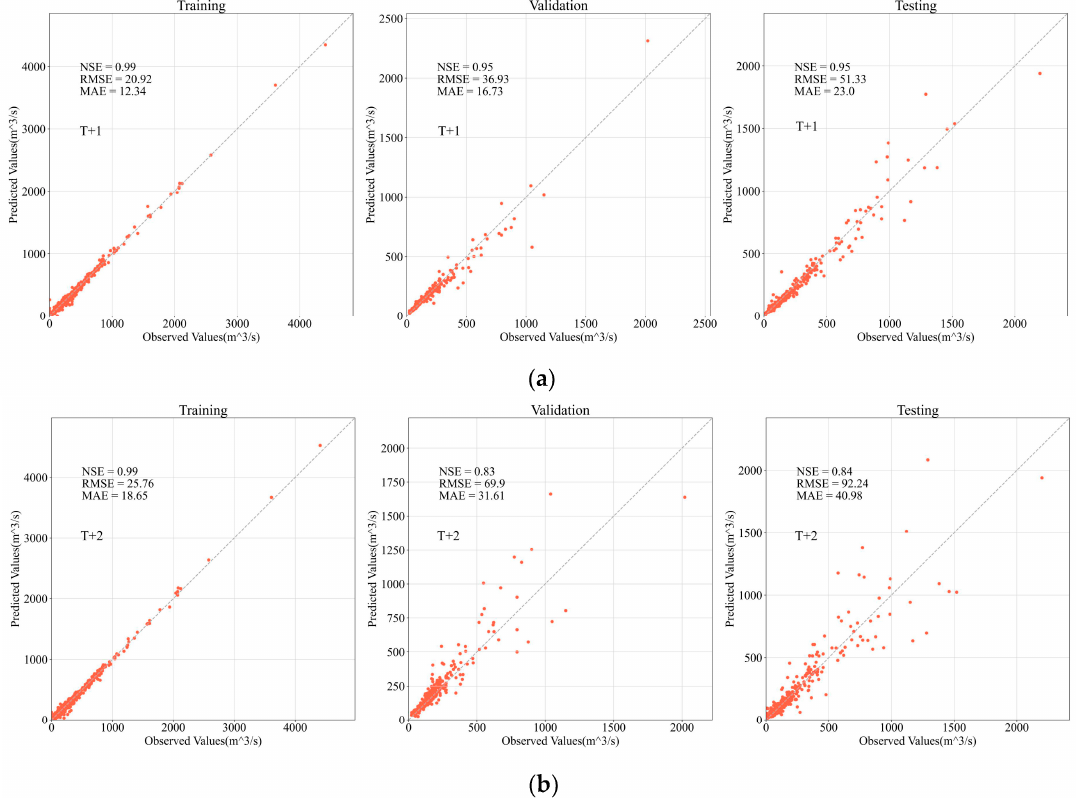
Figure 8. Scatter plots of the fitting results for the best models. ( a ) Fitting result of one-day-ahead (T + 1) forecasting in the training, validation, and testing stage; ( b ) Fitting result of two-day-ahead (T + 2) forecasting in the training, validation, and testing stage.